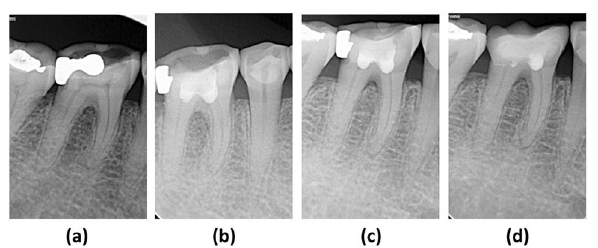
Figure 3. Radiographs of a right mandibular first molar with severe tooth wear and secondary caries in a 63-year-old woman. ( a ) Preoperative radiograph showing occlusal abrasion and a disto-occlusal